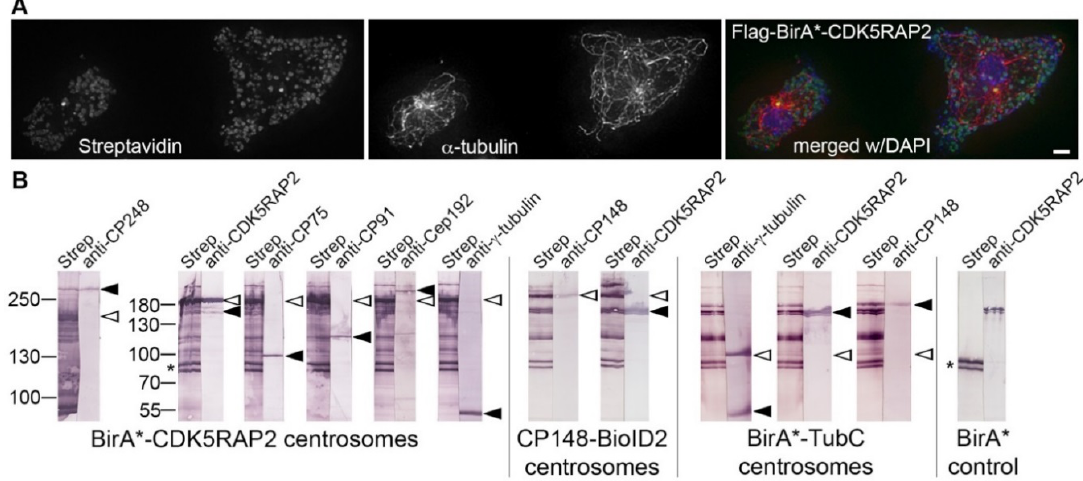
Figure 8. Centrosomal interactions of biotinylase-tagged CDK5RAP2 in the BioID assay. ( A ) Immunofluorescence microscopy ofFlag-BirA-tagged CDK5RAP2RNAi cells stained with anti- α -tubulin and streptavidin-AlexaFluor 488. DNA staining with DAPI is shown in the merged image. The secondary antibody was anti-rat AlexaFluor 568. Cells were fixed with glutaraldehyde. Maximum intensity projections of deconvolved images are displayed. Bar = 2 µm. ( B ) BioID Western blot analysis according to [30]. Centrosome extracts prepared from the cell lines indicated at the bottom were electrophoresed and blotted. Single lanes were cut from broad blots, stained individually with streptavidin-alkaline phosphatase (strep) or antibodies as indicated on top, and re-aligned after staining as shown. Bands were visualized using conjugates with alkaline phosphatase and NBT/BCIP color detection. Positions of the respective fusion proteins always showing self-biotinylation are marked by open arrowheads. Positions of endogenous, biotinylated proteins are labeled by filled arrowheads. The position of the double band representing biotinylated mitochondrial proteins is highlighted by an